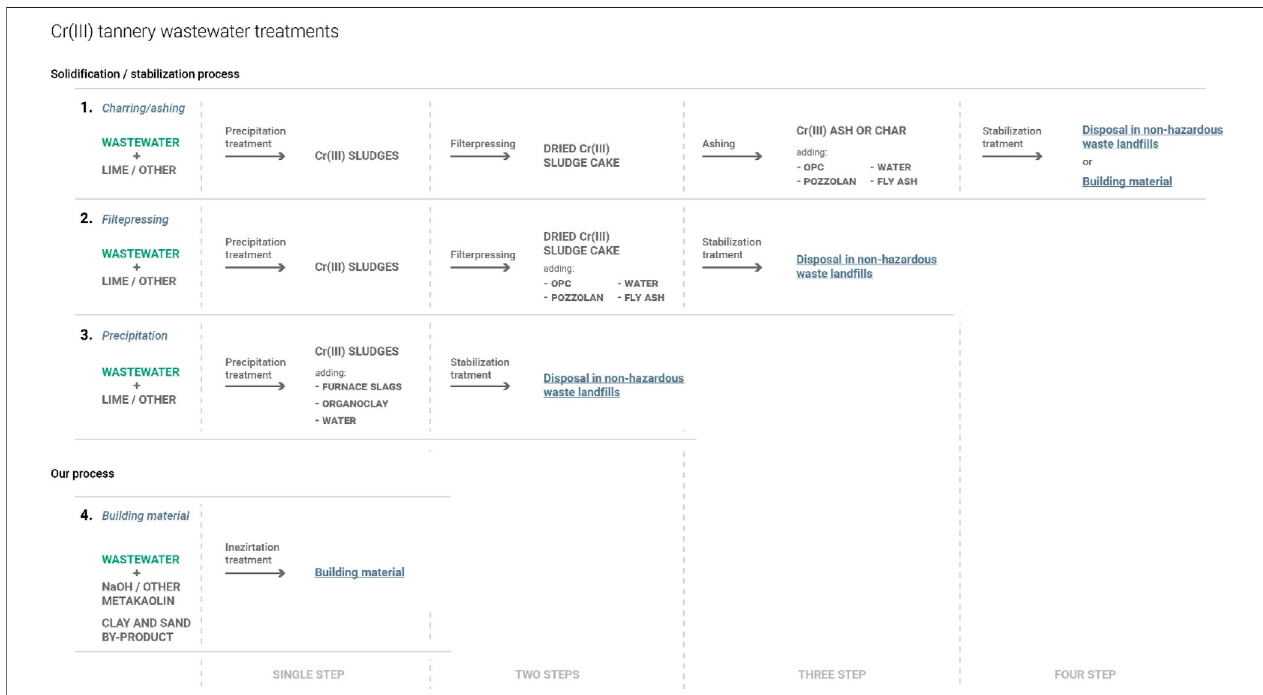
FIGURE1| Simpli fi edsketchsummarizingtheencapsulatingorsolidi fi cation/stabilizationproceduresadoptedforCr(III)-containingtannerywastewaterelaborated from Refs Montañés et al. (2014), Daniil et al. (2018), Pantazopoulou and Zouboulis (2018), Haque et al. (2019), Boldrini et al. (2021).